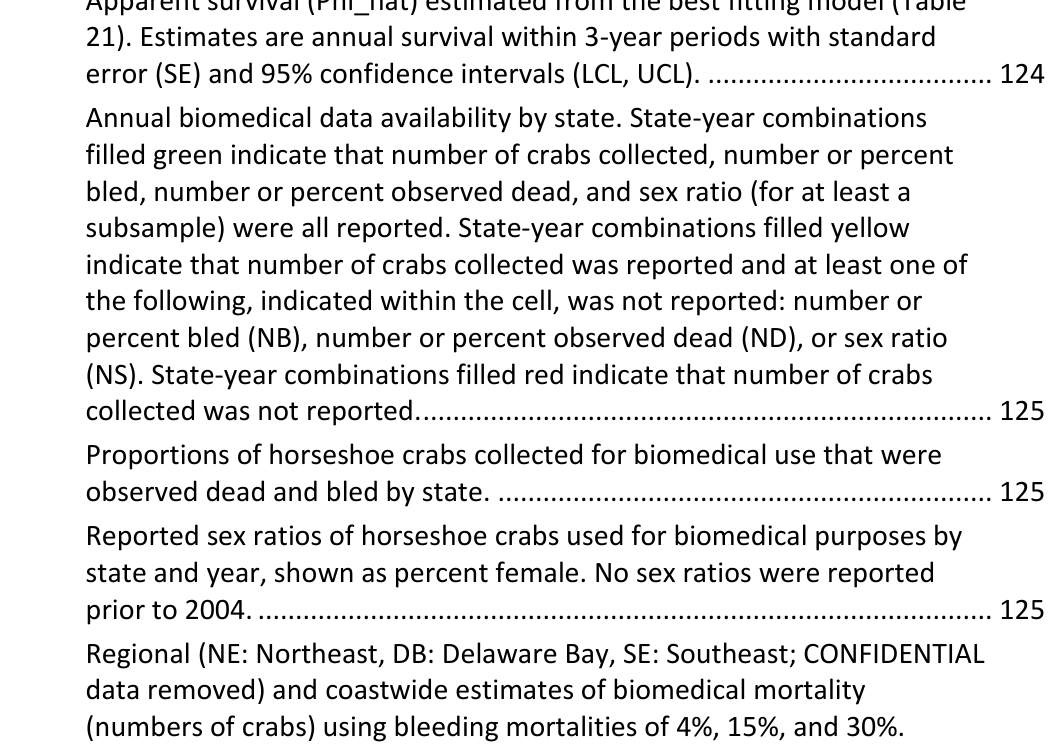
Numbers of horseshoe crabs collected, bled, and estimated mortality for Summary of studies that estimate a mortality rate of crabs bled for biomedical purposes and the same size of crabs bled to obtain the rate. All trawl captured horseshoe crabs that have been tagged and released since 1999. Shaded gray columns indicate biomedical companies that tag List of recaptured trawl-tagged crabs since 1999. Shaded gray columns indicate biomedical companies that tag bled crabs (Lonza and Wako). ........ 122 Total recaptures by years at large (YAL) for all trawl captured, bled male Total recaptures by years at large (YAL) for trawl captured, unbled male Model statistics for the top 6 out of 70 models fit to the capture recapture data for horseshoe crabs tagged in the coastal Delaware and Virginia geographic area between 1999 and 2017. Model names include group and time effects for apparent survival (Phi) and capture probability (p); npar=number of parameters; AICc=corrected Akaike Information Apparent survival (Phi_hat) estimated from the best fitting model (Table 21). Estimates are annual survival within 3-year periods with standard Annual biomedical data availability by state. State-year combinations filled green indicate that number of crabs collected, number or percent bled, number or percent observed dead, and sex ratio (for at least a subsample) were all reported. State-year combinations filled yellow indicate that number of crabs collected was reported and at least one of the following, indicated within the cell, was not reported: number or percent bled (NB), number or percent observed dead (ND), or sex ratio (NS). State-year combinations filled red indicate that number of crabs Proportions of horseshoe crabs collected for biomedical use that were Reported sex ratios of horseshoe crabs used for biomedical purposes by state and year, shown as percent female. No sex ratios were reported Regional (NE: Northeast, DB: Delaware Bay, SE: Southeast; CONFIDENTIAL data removed) and coastwide estimates of biomedical mortality (numbers of crabs) using bleeding mortalities of 4%, 15%, and